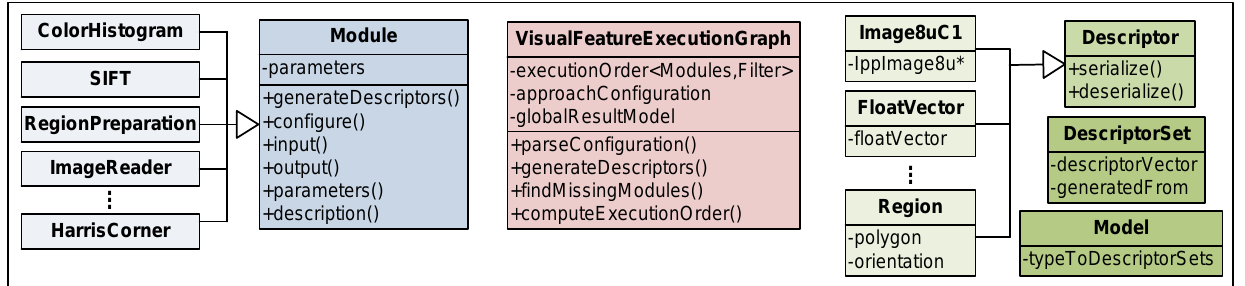
Figure 7. Class diagram of modules, descriptors, and extraction